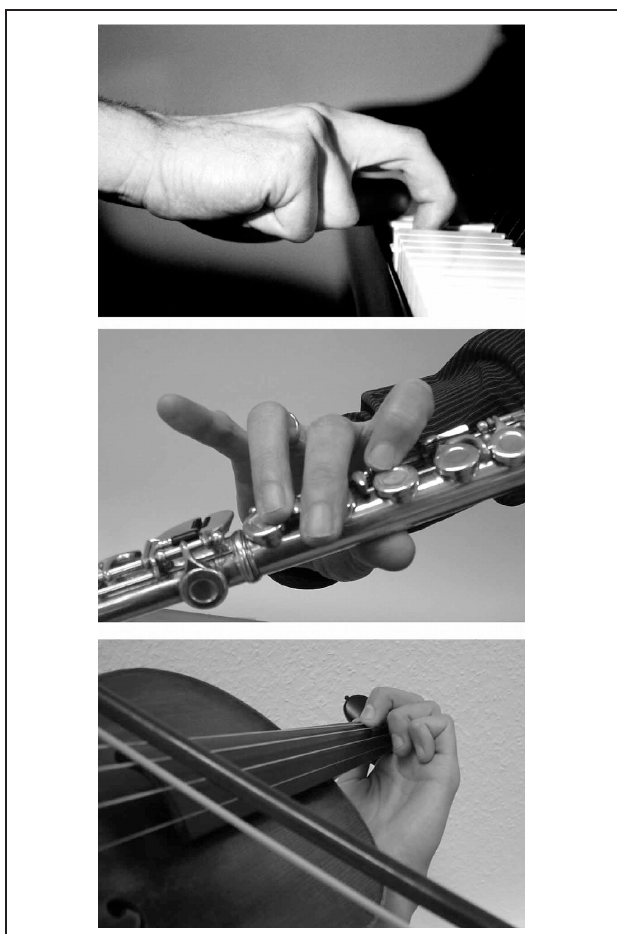
FIGURE 1 | Typical patterns of dystonic postures in a pianist, a violinist, a flutist. Note the involuntary flexion of the ring and little fingers (digits 4 and 5) in the pianist and violinist. The flutist’s index finger is involuntarily flexed while middle, ring and little fingers attempt to compensate by